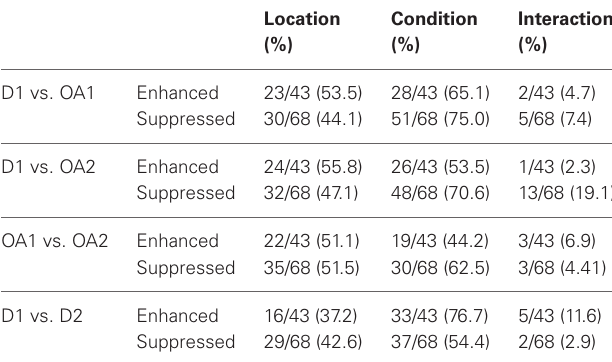
Table 3 | Results of 2 factor ANOVA of reach period activity for all cells.